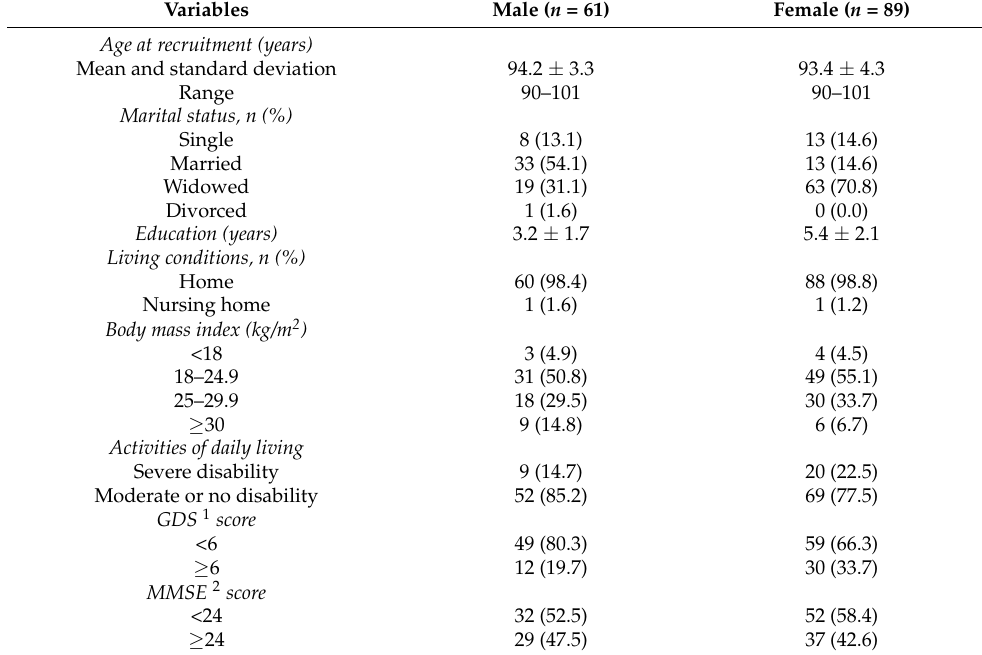
Table 1. Demographic features of study